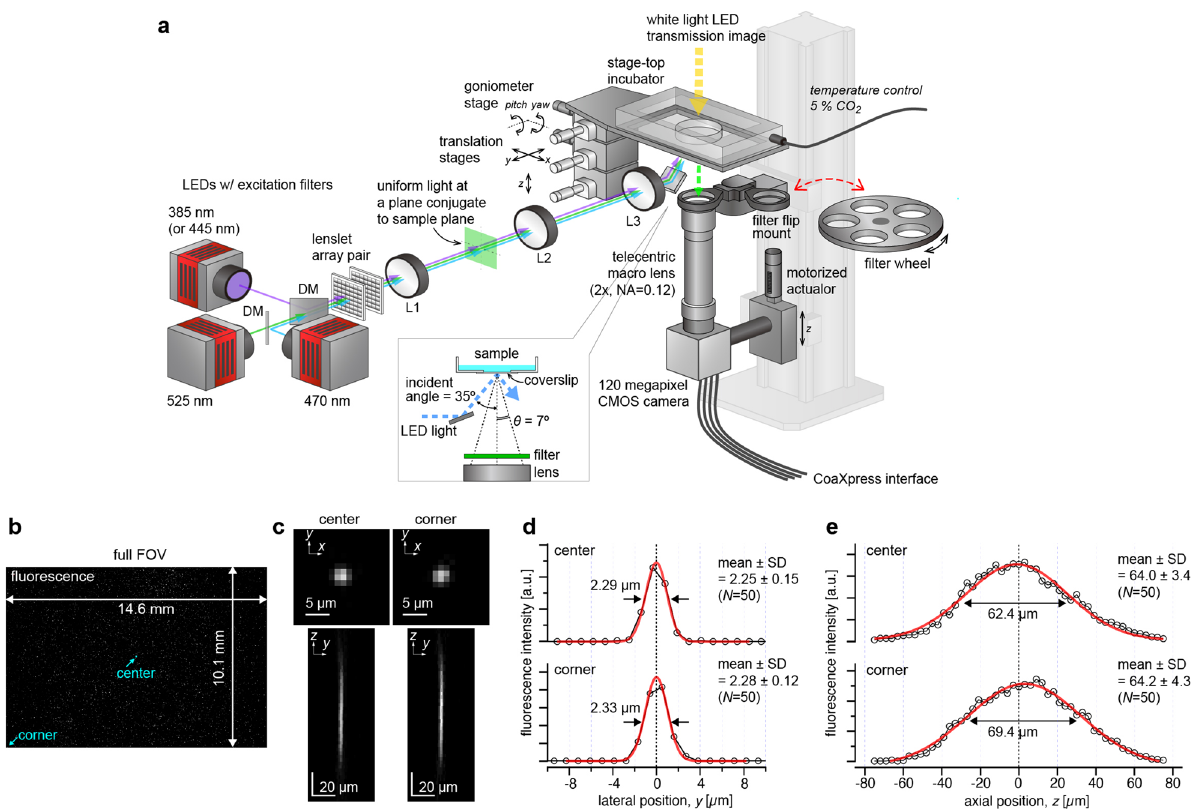
Figure 1. Configuration and performance of the trans-scale imaging system AMATERAS1.0. ( a ) Schematic representation of the system configuration. See “Methods” for detail. ( b – e ) Evaluation of the imaging performance with fluorescent beads of 200 nm in diameter dispersed on a glass-bottom dish. The central wavelength of LED-excitation was 470 nm, and the emission peak wavelength was 520 nm. ( b ) An image captured with full FOV. ( c ) Representative images of individual beads in a transverse plane ( xy plane) and a longitudinal plane ( yz plane) at the center and the corner of the FOV (indicated by light-blue arrows in b ), which can be regarded as PSF. The yz plane image is a longitudinal cross-section of an image-stack obtained by scanning the sample-lens distance in the z -direction. ( d ) Line profiles depicting the fluorescence intensities on the y -axis at the in-focus plane ( c , top), shown with black circles. ( e ) Line profiles depicting the fluorescence intensities on the z -axis penetrating the center of the PSF ( c , bottom), shown with black circles. The red lines in ( d – e ) represent a Gauss function curve fit to the experimental